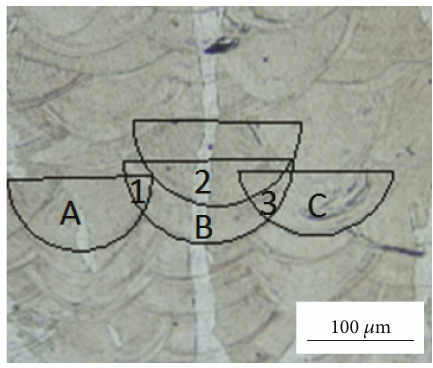
Figure 19: The pool boundaries of the sample 2 fabricated by SLM.